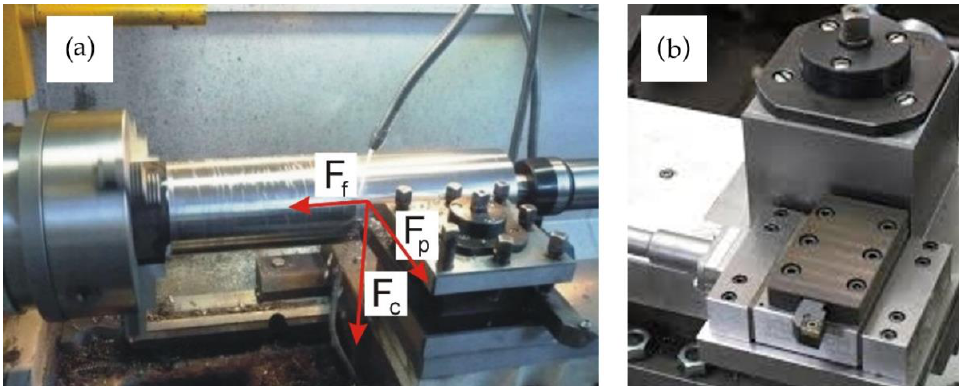
Figure 1. Test bench: ( a ) General view of the bench with a shaft secured in the lathe and main machining forces; ( b ) apparatus for measuring turning forces.